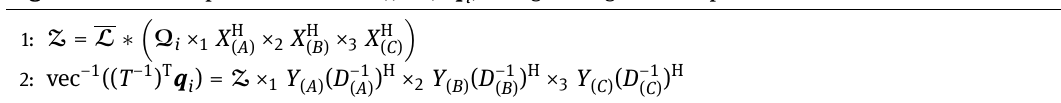
Algorithm 3-2 Computation of vec −1 (( T −1 ) T q